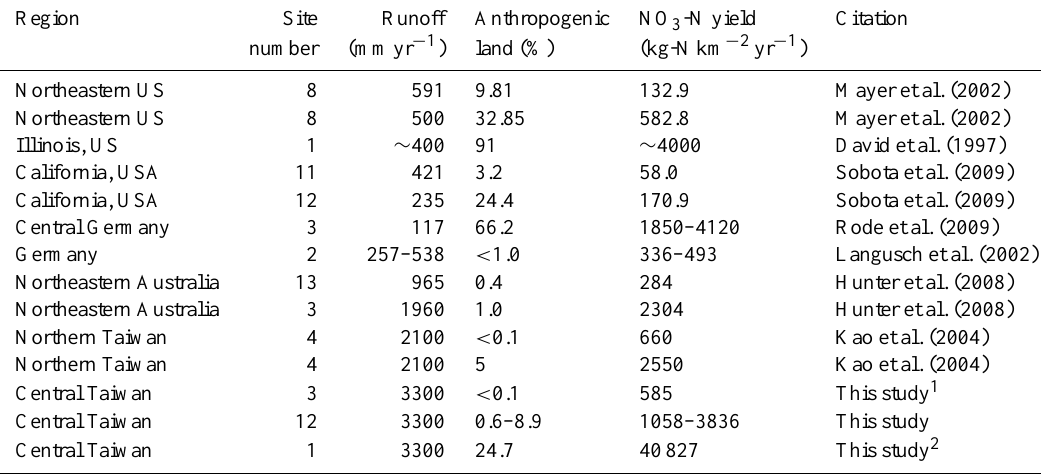
Table 7. The annual NO 3 -N flux observed in this study and those around the world.